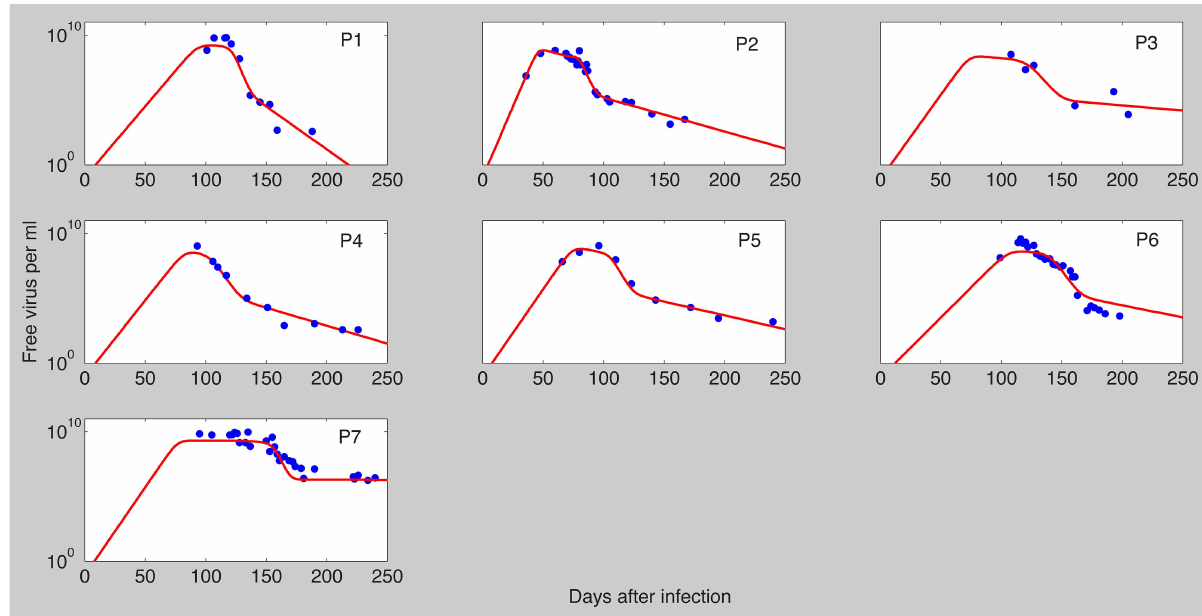
Figure 1. The best fit of V as given by model (7) (solid lines) to patient data ( . ). Best parameter estimates are presented in Table 2. The other parameters are as in Table 1.